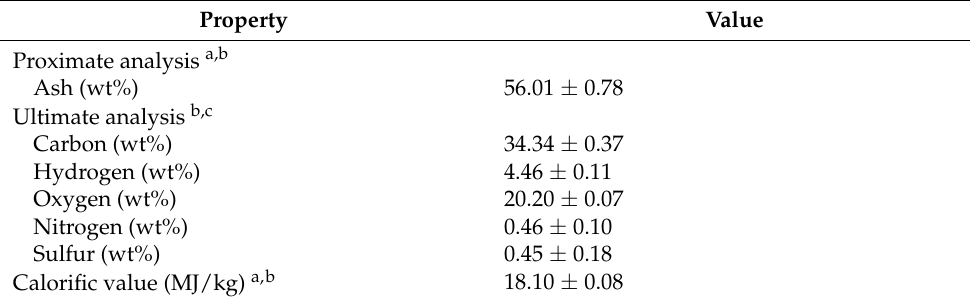
Table 1. Ash content, elemental analysis and calorific value of oil-containing